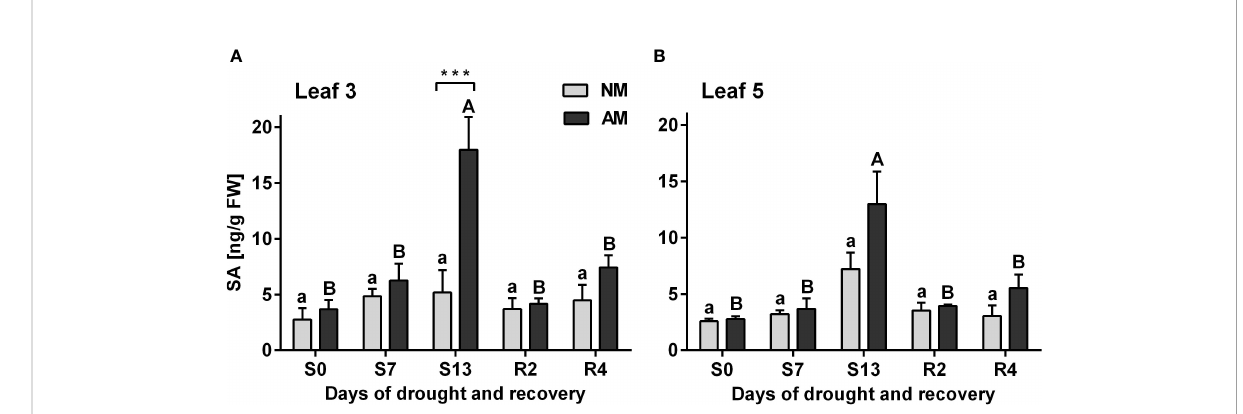
FIGURE 4 Salicylic acid accumulation patterns for L3 (A) or L5 (B) leaves at subsequent time points of drought development (S0-S13) and rehydration (R2, R4), in relation to the presence (AM) or the absence (NM) of mycorrhiza. Bars represent mean values and standard error of mean (n=6). Statistically signi fi cant differences between AM and NM means, calculated using Students t -test are presented with asterisks (*** p <0.001). Lower-case letters show signi fi cant differences between NM means and upper-case letters signi fi cant differences between AM means in following days calculated using ANOVA